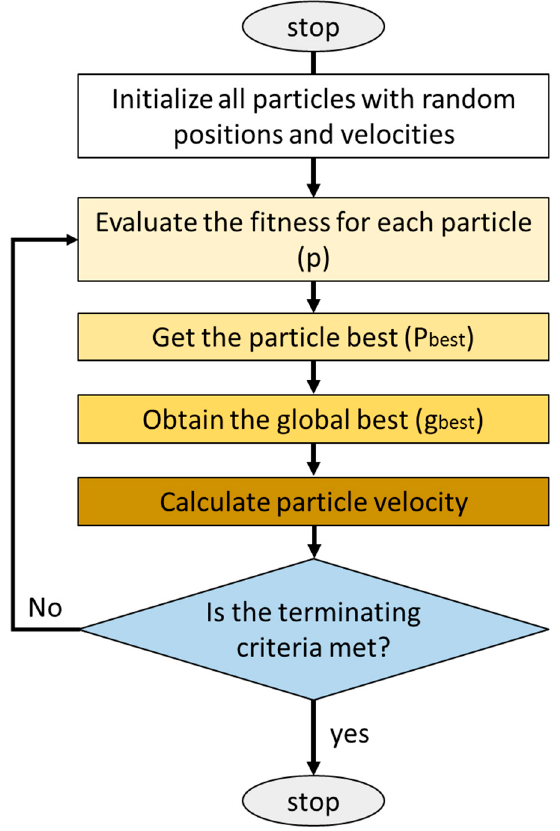
Figure 4. The initial algorithm of PSO (after Phuong-Thao et al. [33]).